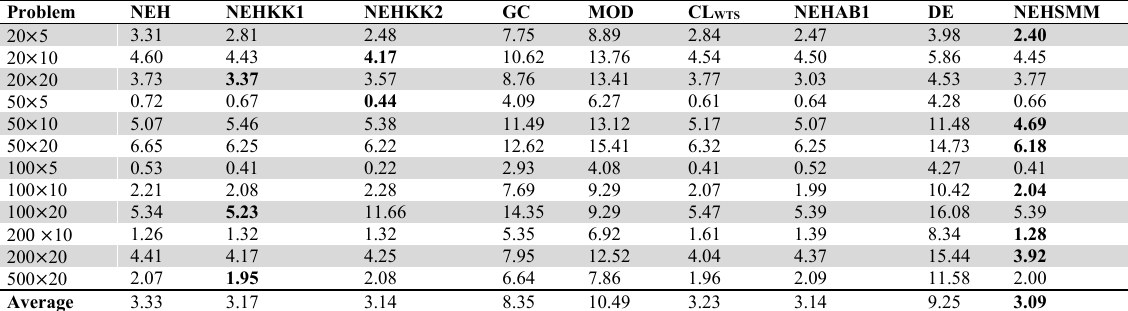
ARPD values of different heuristics on Taillard's test bed Problem NEH